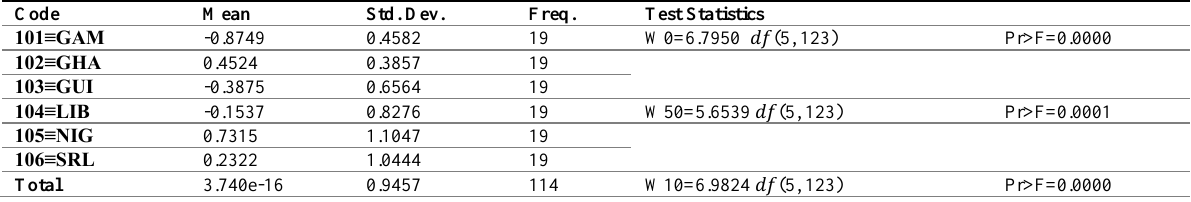
Table 2: Summary Statistics for test of pooled